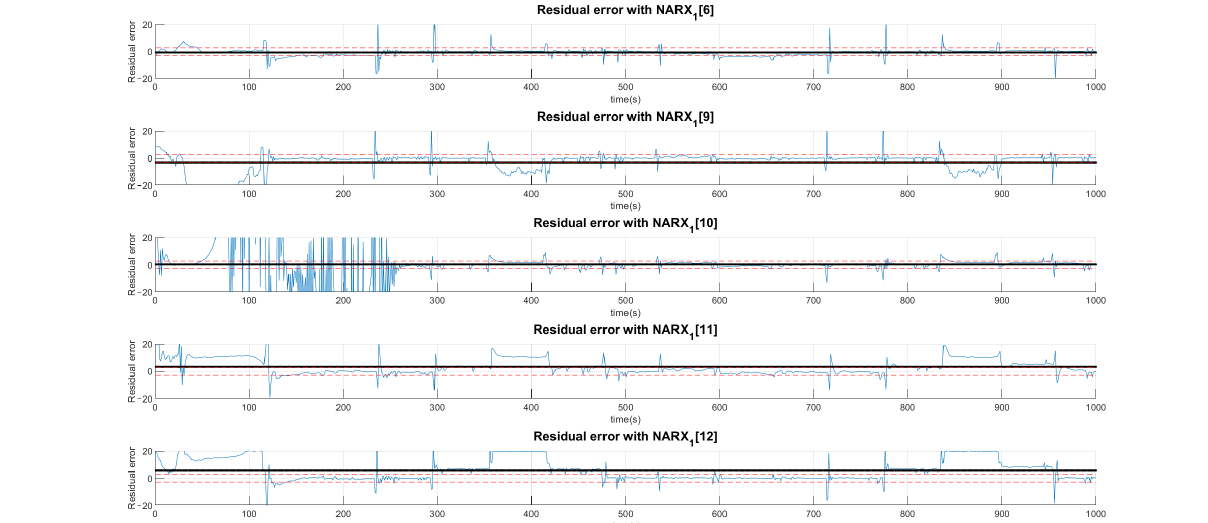
Figure 15. Residual analysis with the second layer of the network excluding those that did not have limits close to zero in the first layer. In this excerpt the residual values for the situations are presented: Faults F6, F9, F10, F11 and